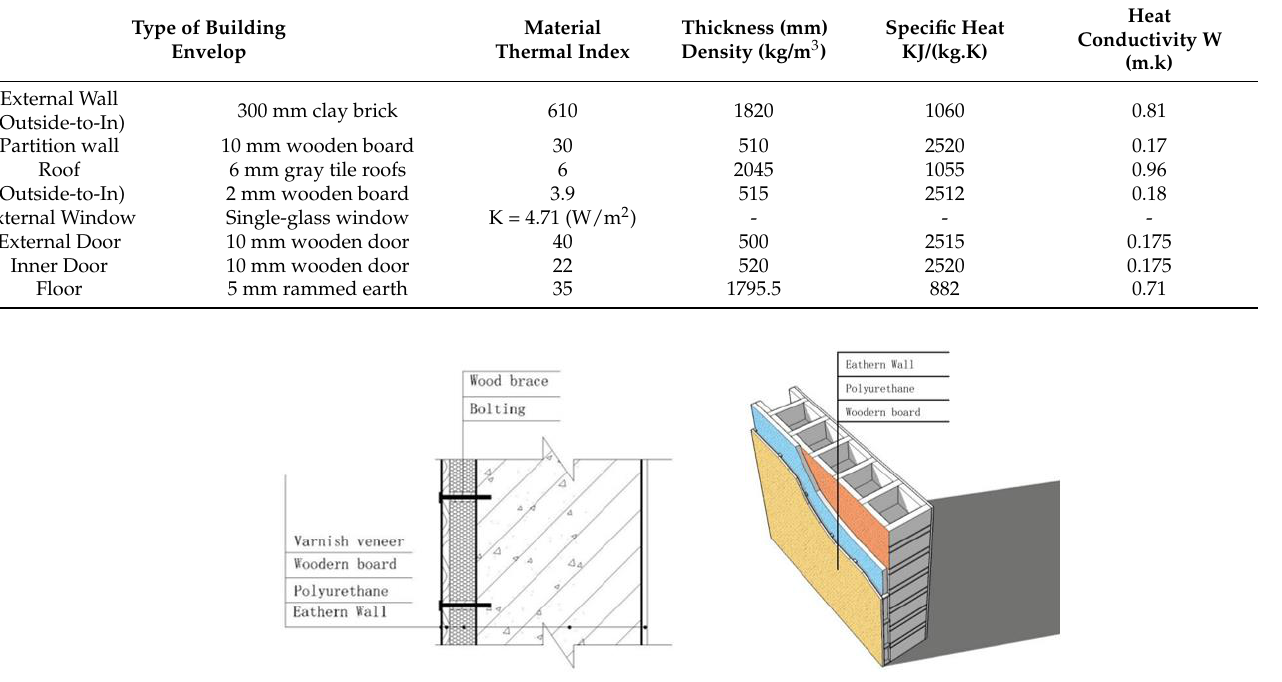
Table 5. Material settings of the traditional dwelling envelope.